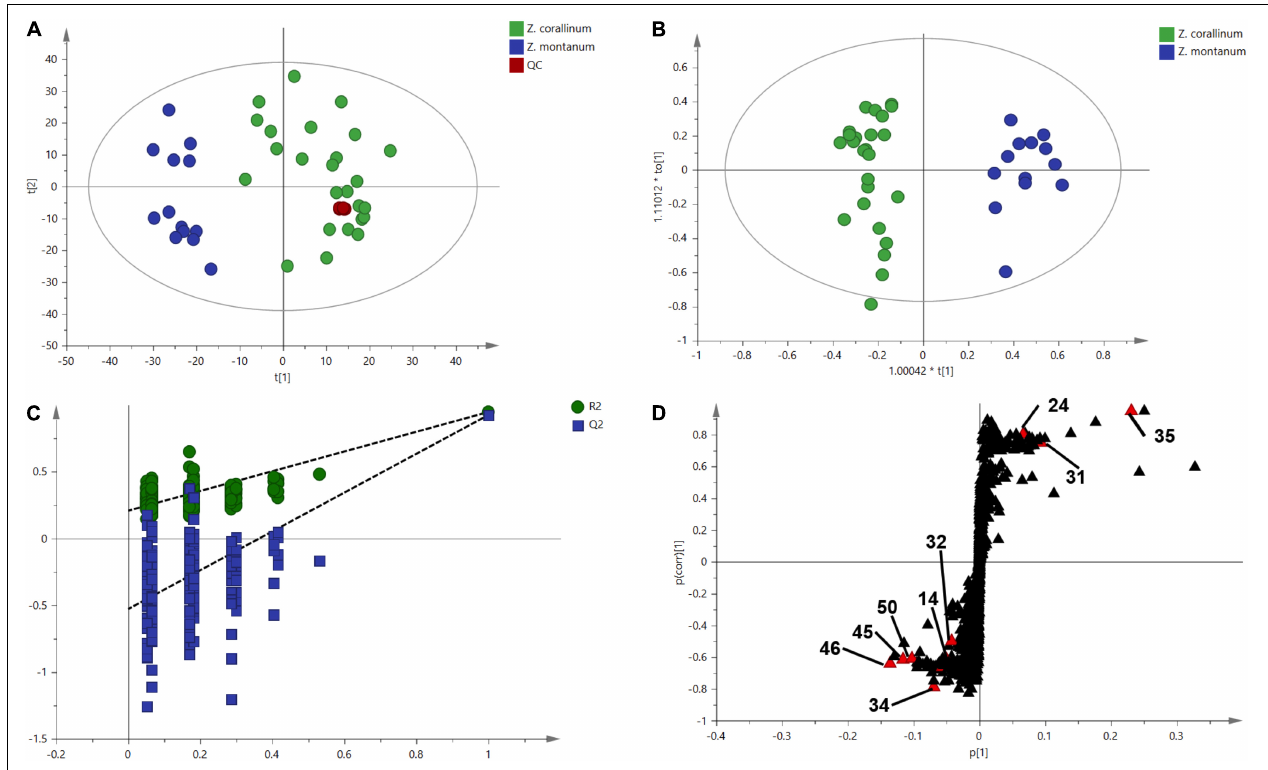
FIGURE 4 | Multivariate statistical analysis of the training set from gas chromatography-mass spectrometry (GC-MS). The green, blue and red circles represent Z. corallinum , Z. montanum, and QC samples: (A) PCA score plot, the x-axis and y-axis, respectively, represented the correlation coefficient between the variance and the first two principle components (t1 and t2) which accounted for 26.1 and 19.7% of total variance, respectively; (B) Orthogonal partial least squares discrimination analysis (OPLS-DA) scores plots of Z. corallinum vs. Z. montanum , the x-axis and y-axis represented the weights of the regression coefficients of the predicted principal components and orthogonal principal components, respectively; (C) 200-permutation test of OPLS-DA models, the x-axis represented the accuracy of the model, and the y-axis represented the frequency of the accuracy of the 200-permutation test; (D) S-plot diagram comparing the Z. corallinum and Z. montanum groups, S-plot provides visualization of the OPLS-DA predictive component loading to facilitate model interpretation.